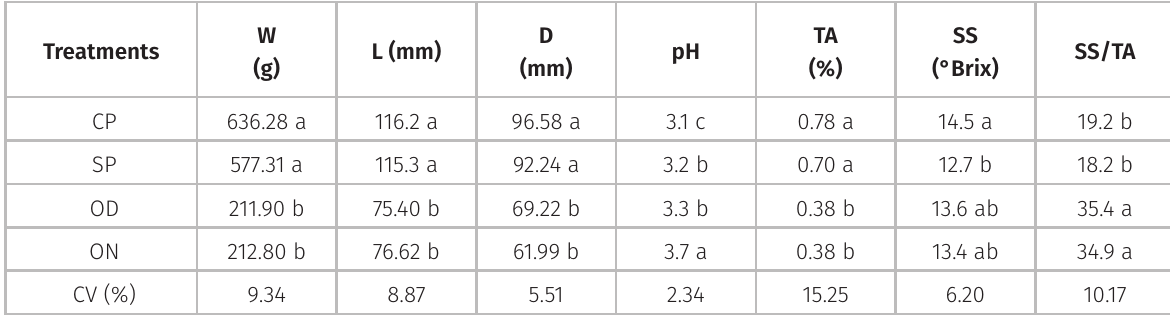
Table I. Fruit weight (W), length (L), diameter (D), pH, titratable acidity (TA), soluble solids (SS), and SS/TA ratio. Pollinations performed on 02/13/19. Treatments: cross-pollination (CP), self-pollination (SP), diurnal open pollination (OD), and nocturnal open pollination